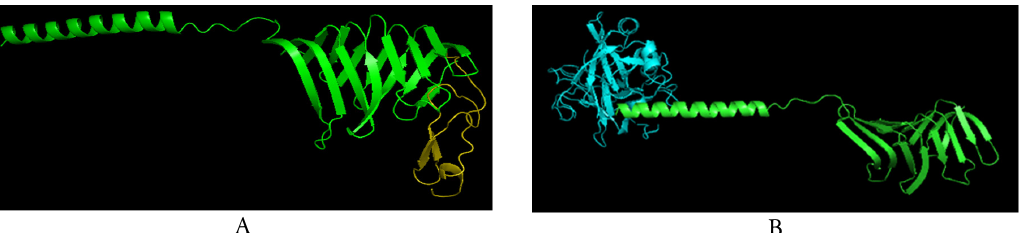
Figure 2. Vibrio cholerae lipopolysaccharide protein docking using PyMOL; (A) Vibrio cholerae lipopolysaccharide protein with coagulation factor VII (yellow); (B) Vibrio cholerae lipopolysaccharide protein with coagulation factor II (cyan)